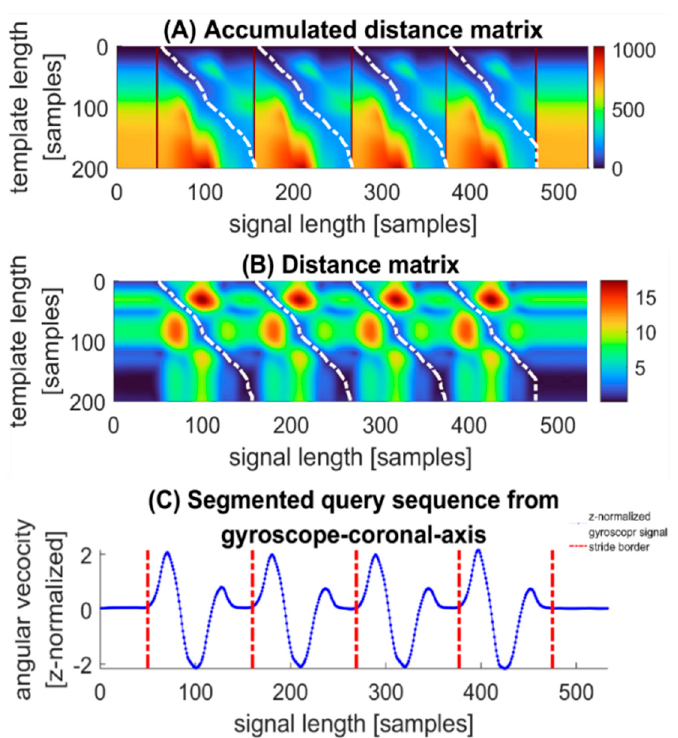
Figure 7. ( A ) The white lines represent the warping paths which correspond to best-matched subsequences in the query sequence. By using the augmented time warping scheme, the best-match subsequences could be detected and borders of strides recognized. Dark red ribbons between two warping paths indicate the borders of detected stride segments. They display the accumulated distances that are positive infinite resulting from star-padding. ( B ) The warping paths in distance matrix just run through the deep blue area from top to bottom, which is consistent with the hypothesis in Section 2.5.3. ( C ) After applying the time range of warping paths to the time axis of IMU data, the stride borders are available, which are represented as red vertical lines. Additionally, the stride segments just look like template.